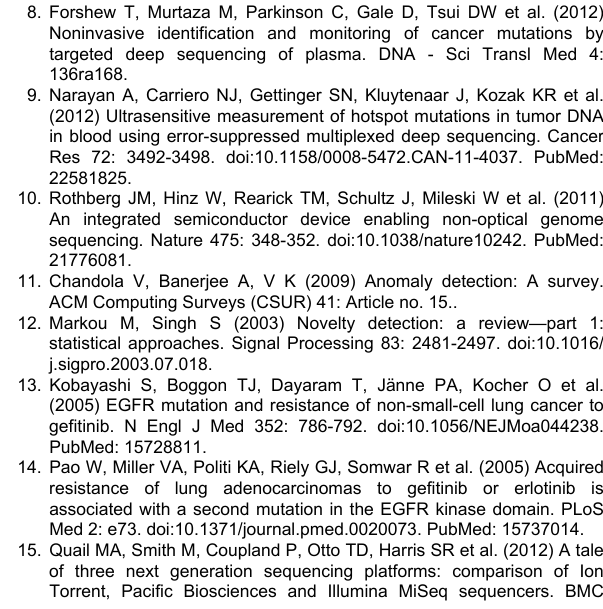
Table S5. List of primers with index and